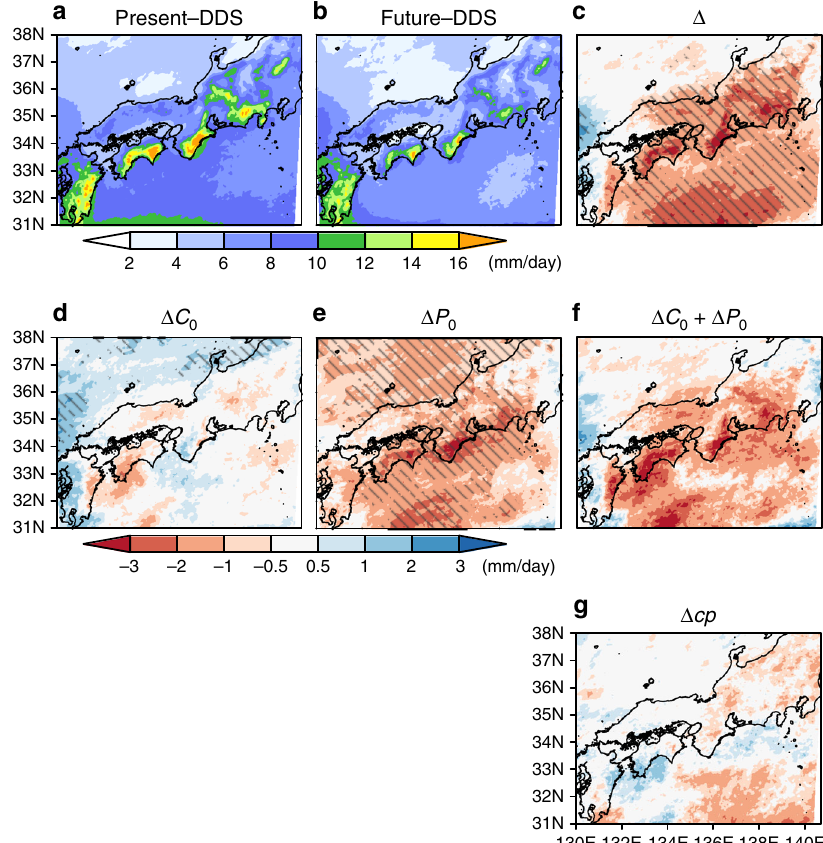
Fig. 2 Spatial distribution of precipitation changes. Twenty- fi ve-year averages of the daily precipitation in a Present-DDS, b Future-DDS and c the difference between Present-DDS and Future-DDS. The contributions of the climatology, perturbation and nonlinear effect are shown in d , e , g , respectively. The daily precipitation change estimated by the expected climate change is shown in f . The hatched regions in c – e represent the area in which the difference from Present-DDS is statistically signi fi cant with a 95% con fi dence